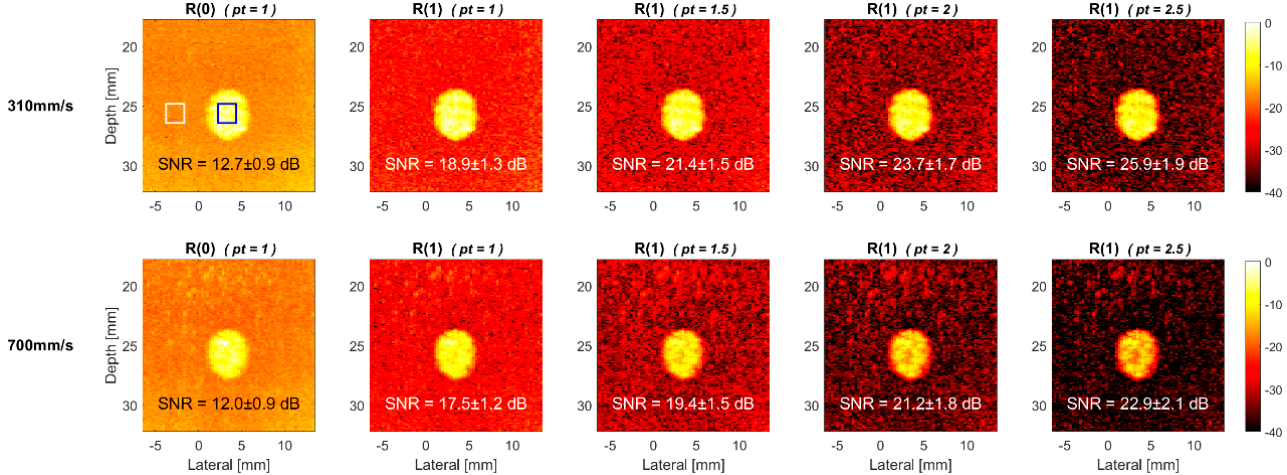
Figure 11. Experimental TMAS power Doppler images of cross-view flow phantom for R(1) images with the pt values of 1.0, 1.5, 2.0 and 2.5, respectively from left to right. R(0) image is also provided as a reference. The flow velocity is 310 mm/s ( upper ) and 700 mm/s ( lower ). The inclined angle of the flow vessel is 0°.